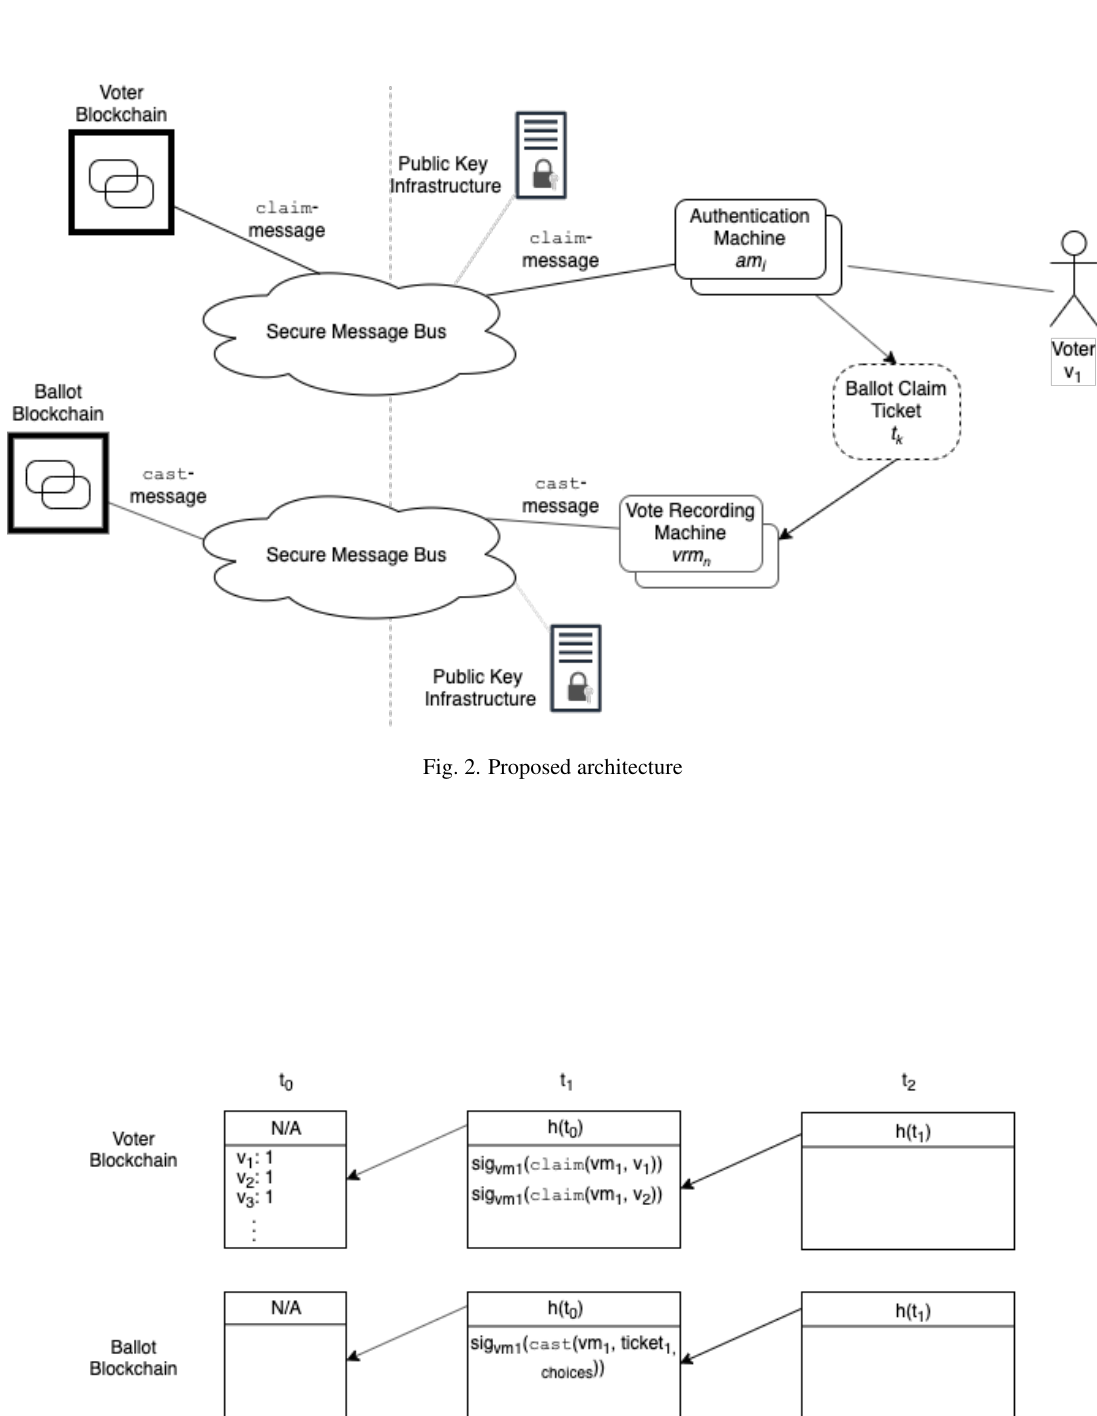
Fig. 3. Transactions on the